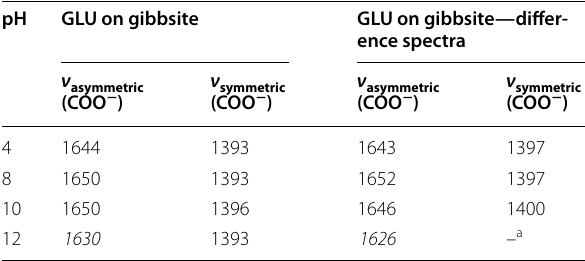
Table 6 Wavenumbers ν [cm − 1 ] of asymmetric and sym- metric carboxylate stretching vibrations of GLU